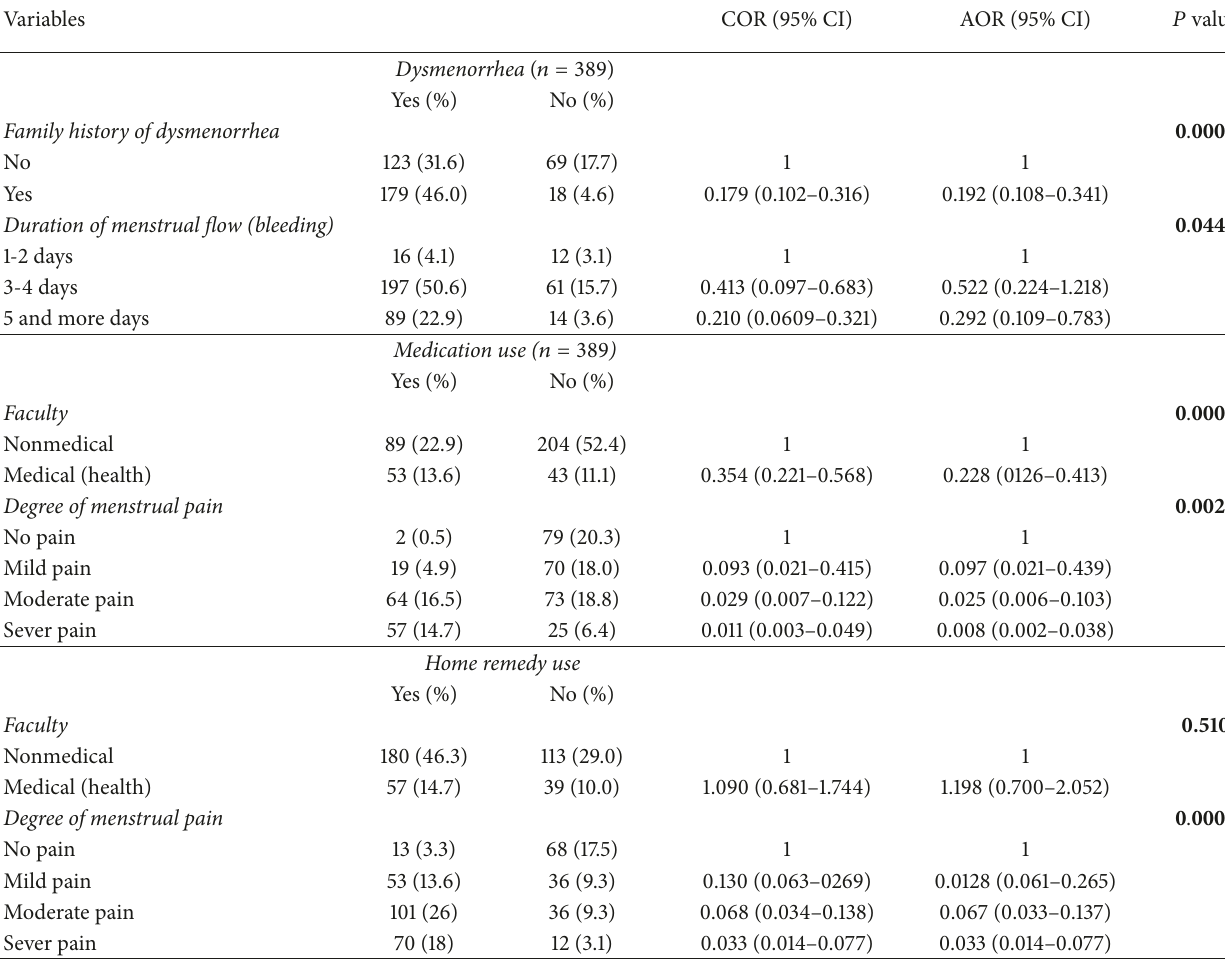
Table 3: Predictors of dysmenorrhea, medication, and home remedy use, Gondar, 2016.